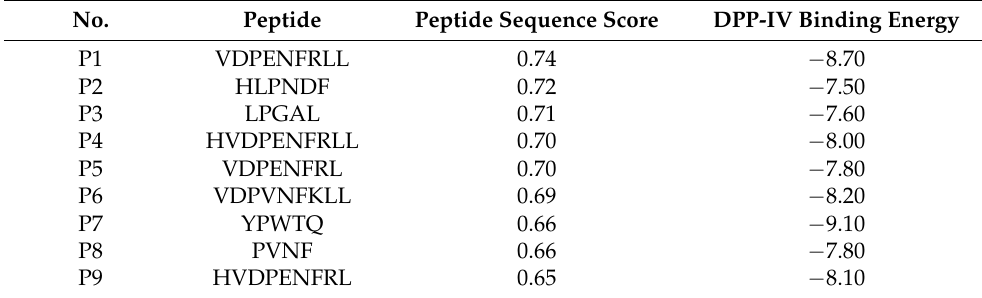
Table 4. Peptide Ranker score and binding energy data for